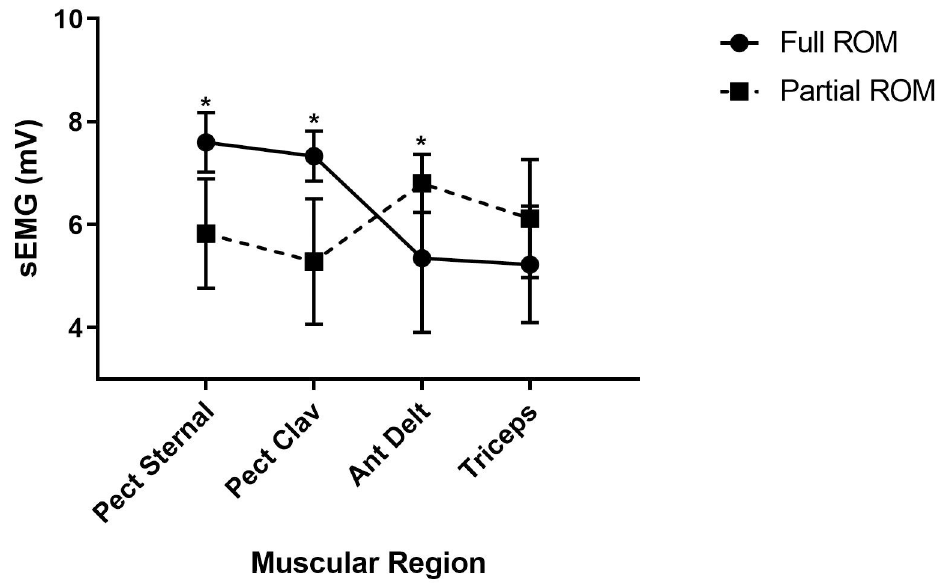
Fig 3. Comparisons of electromyographic signal. sEMG = Electromyographic signal; Ant Delt: anterior portion of the deltoid muscle; Pect Clav: clavicular portion of the pectoralis major muscle; Pect Sternal: sternal portion of the pectoralis major muscle; � p <